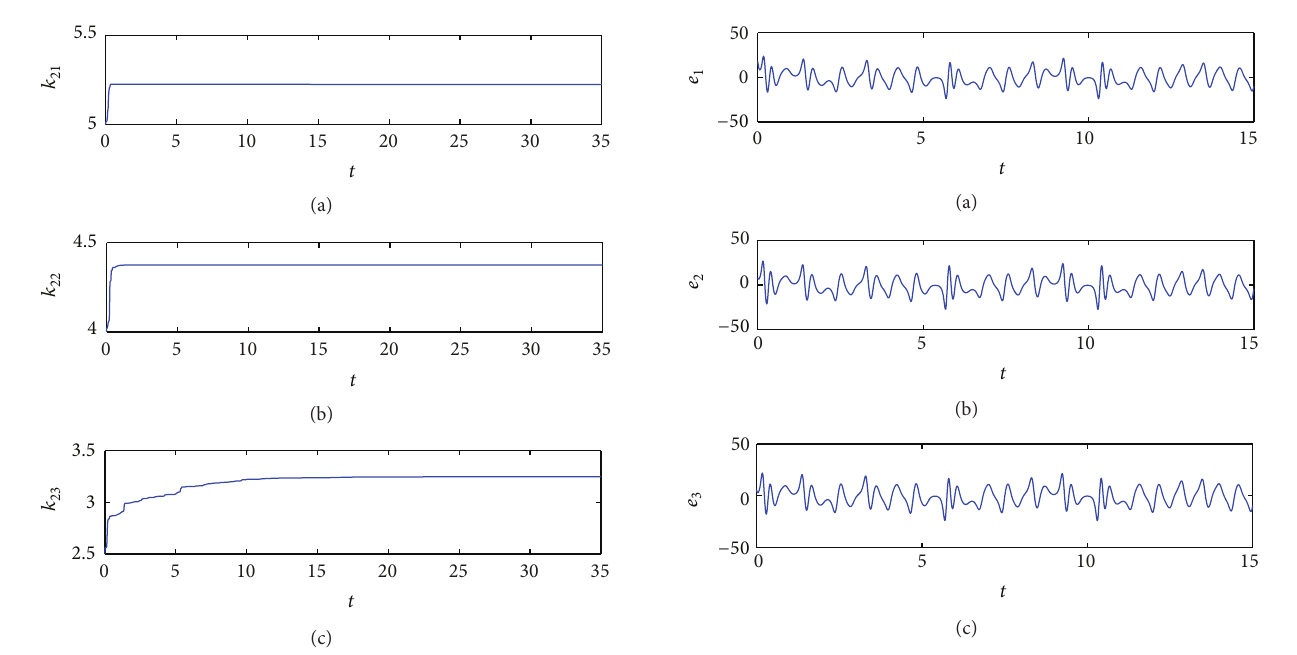
Figure 12: The trajectories of the error system without control input in Example 2.